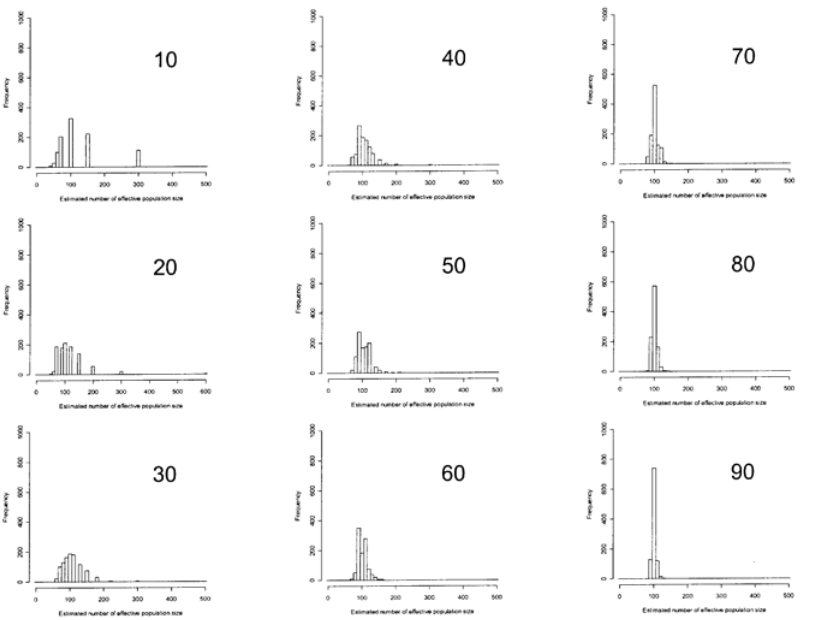
Fig. 3 The histograms of the estimated effective population size using two sample sets which are the 30 individuals from the first generation and 10, 20, 30, 40, 50, 60, 70, 80, 90 individuals from the second generations in computer simulations. The upper right number of each graph is the number of samples of the second